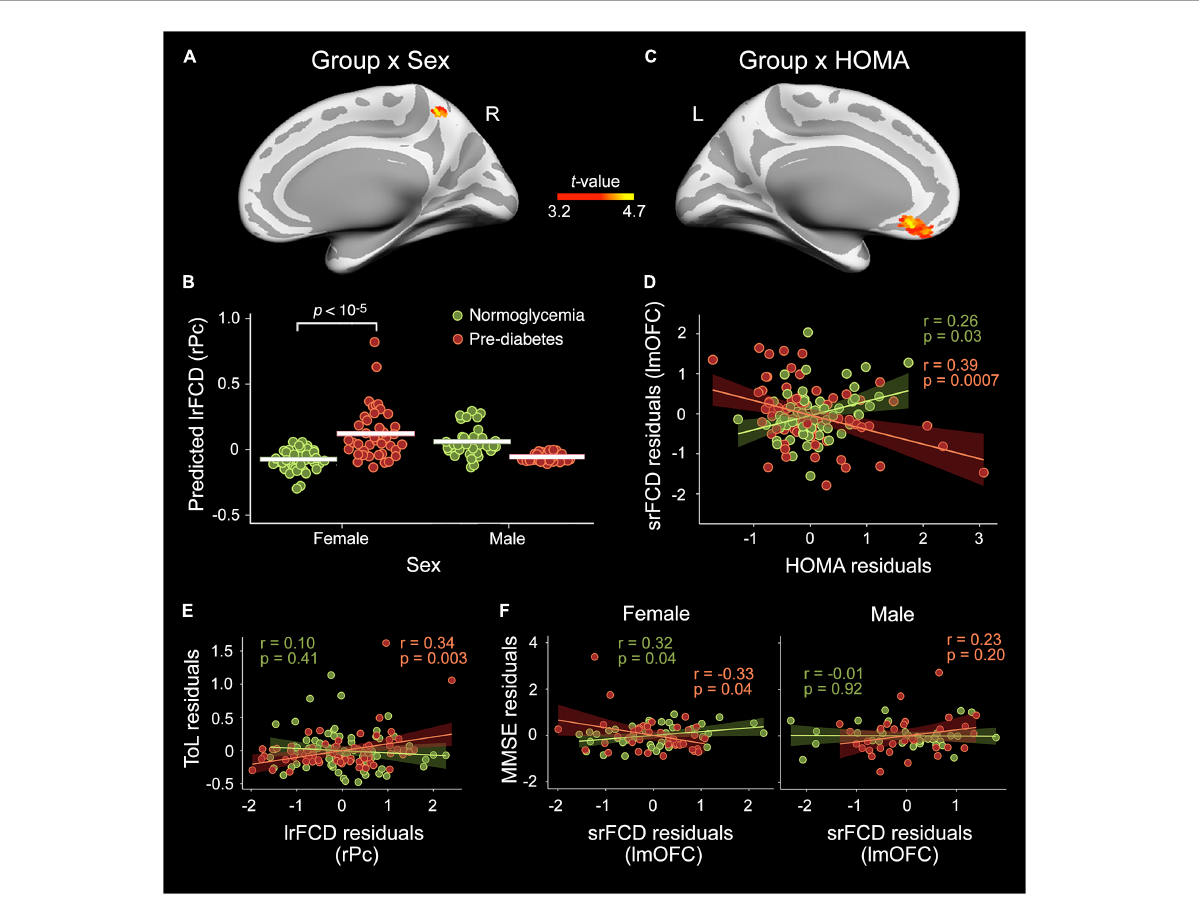
FIGURE1 Moderating role of sex and homeostatic model assessment (HOMA) in the pre-diabetes-related alterations in functional connectivity density (FCD) cortical hubs. Effect of group × sex interaction in the long-range FCD (lrFCD) of the right precuneus (rPc) (A,B) and in the short-range FCD (srFCD) of the left medial orbitofrontal cortex (lmOFC) (C,D) after adjustment by age, sex, years of education, BMI, A/L ratio, CRF, and MS status. The shaded areas in the scatter plot reflect the confidence intervals (95%) for the fitted values. (E) Scatter plot illustrating the interaction between group and lrFCD in the rPC on the Tower of London (ToL) test scores. (F) Scatter plots illustrating the interaction between group, sex and srFCD in the lmOFC on Mini-Mental State Examination (MMSE)